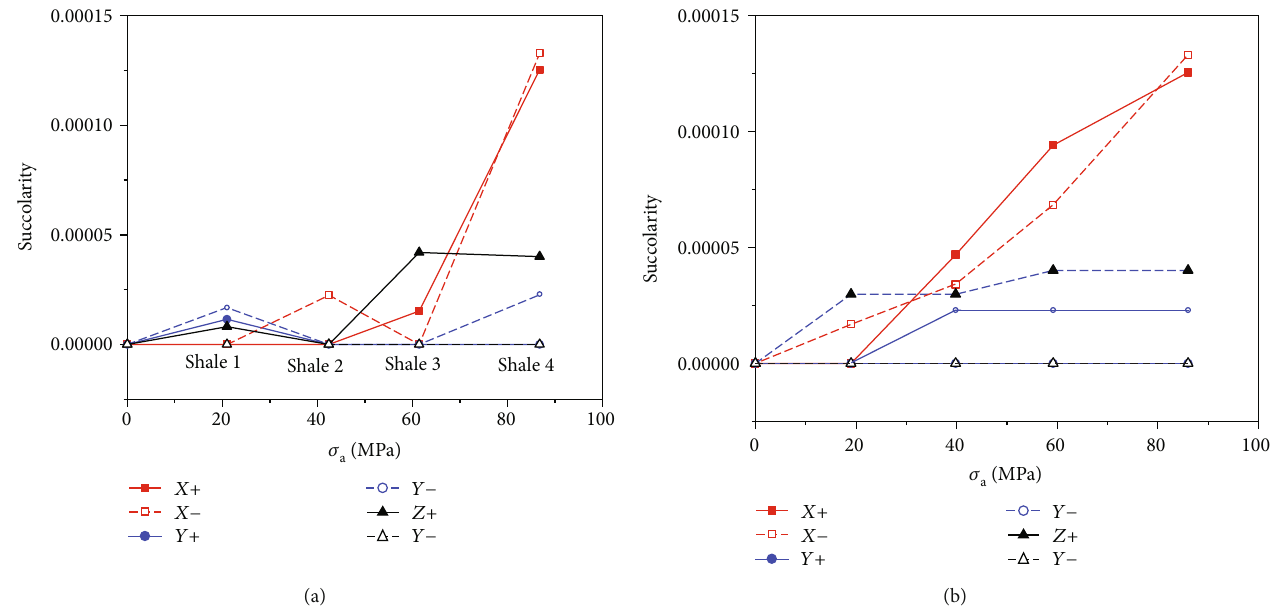
Figure 13: The succolarity-stress curve: (a) shales 1-4; (b) shale 4 under di ff erent stresses.